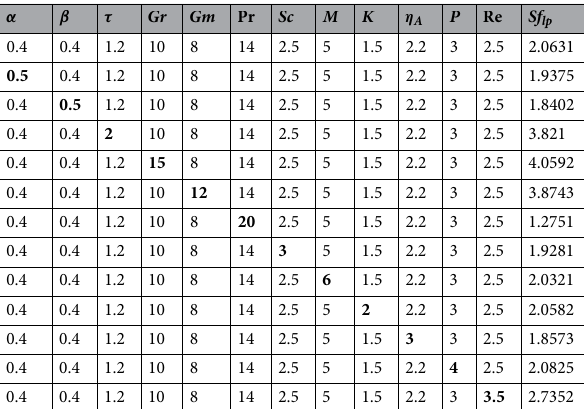
Table 1. The skin friction of couple stress fluid at left